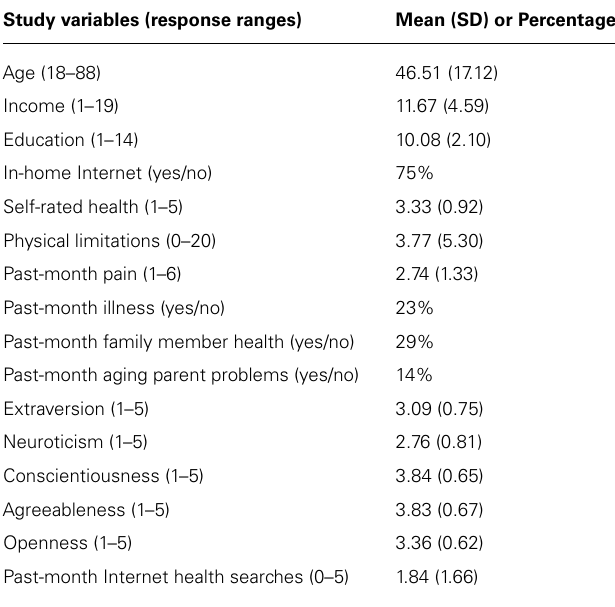
Table 1 | Descriptive statistics for study